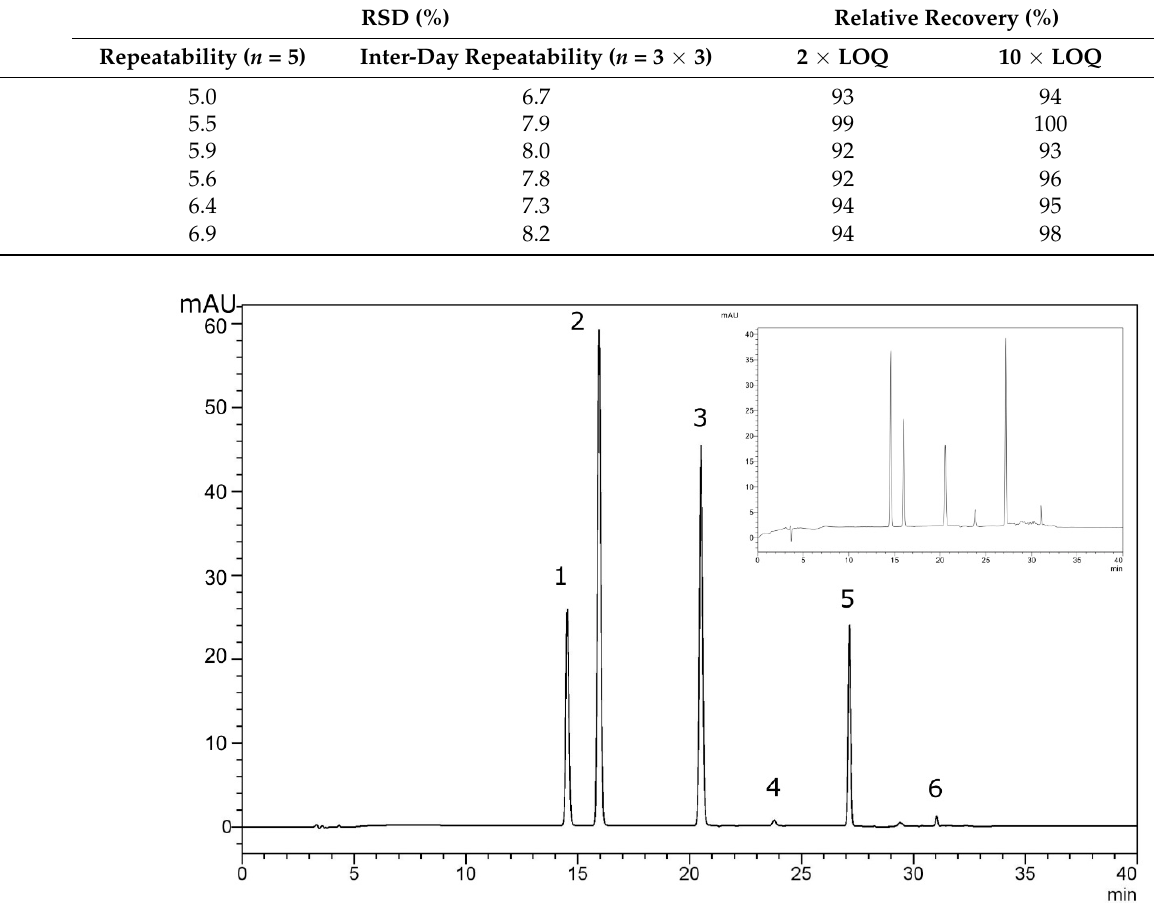
Figure 8. Chromatogram of the extract obtained from a spiked lake water sample (10 µ g L − 1 ) with diode array detector (254 nm) using the proposed procedure; 1: 4OH-BP; 2: PPB; 3: BPB; 4: TCP; 5: BP-3; 6: OCP. The discrepancies of peak heights are attributed to the different molecular absorption maxima of analytes. Inset: the chromatogram at 286 nm. Table 1. Analytical figures of merit of the developed analytical method.